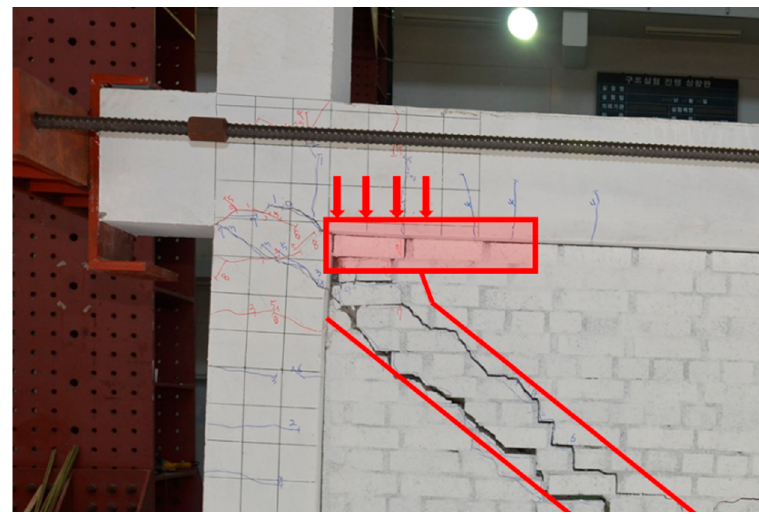
Figure 7. Gap closure due to lateral displacement (IFS-1.0).